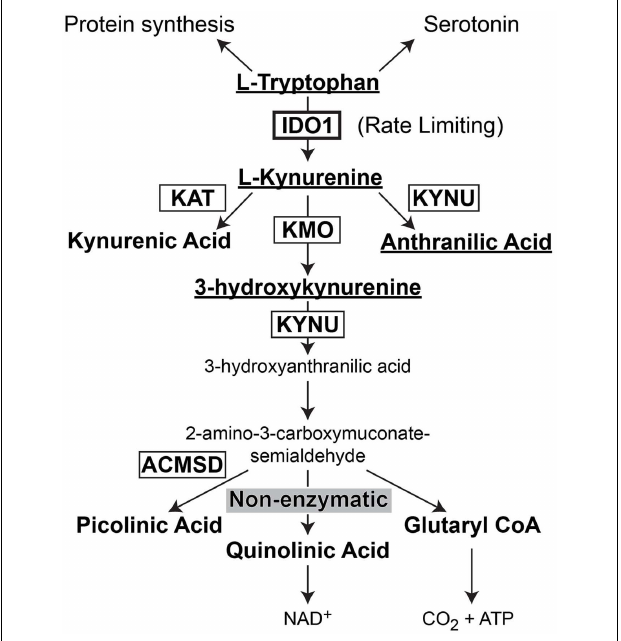
FIGURE 2 | Schematic representation of l-Tryptophan consumption in the body . l-tryptophan is an essential amino acid that is utilized during protein synthesis. In the presence of tryptophan hydroxylase and the co-factor, iron (not shown), l-tryptophan is converted to the neurotransmitter, serotonin. However, in the presence of indoleamine 2,3-dioxygenase 1 (IDO), l-tryptophan is converted to l-kynurenine. l-kynurenine can then be converted to kynurenic acid, 3-hydroxykynurenine, or anthranilic acid via kynurenine aminotransferase (KAT), kynurenine 3-monooxygenase (KMO), and kynureninase [KYNU (also known as l-kynurenine hydrolase)], respectively. 3-hydroxyanthranilic acid is converted by 3-hydroxyanthranilic acid oxygenase (not shown) to 2-amino-3-carboxymuconate-6-semialdehyde.This downstream catabolite can further be catabolized to the final metabolic products of picolinic acid via picolinic carboxylase [also known as 2-amino-3-carboxymuconate-6-semialdehyde-dacarboxylase (ACMSD)], quinolinic acid through a non-enzymatic process or glutaryl CoA through a series of oxido-reductive